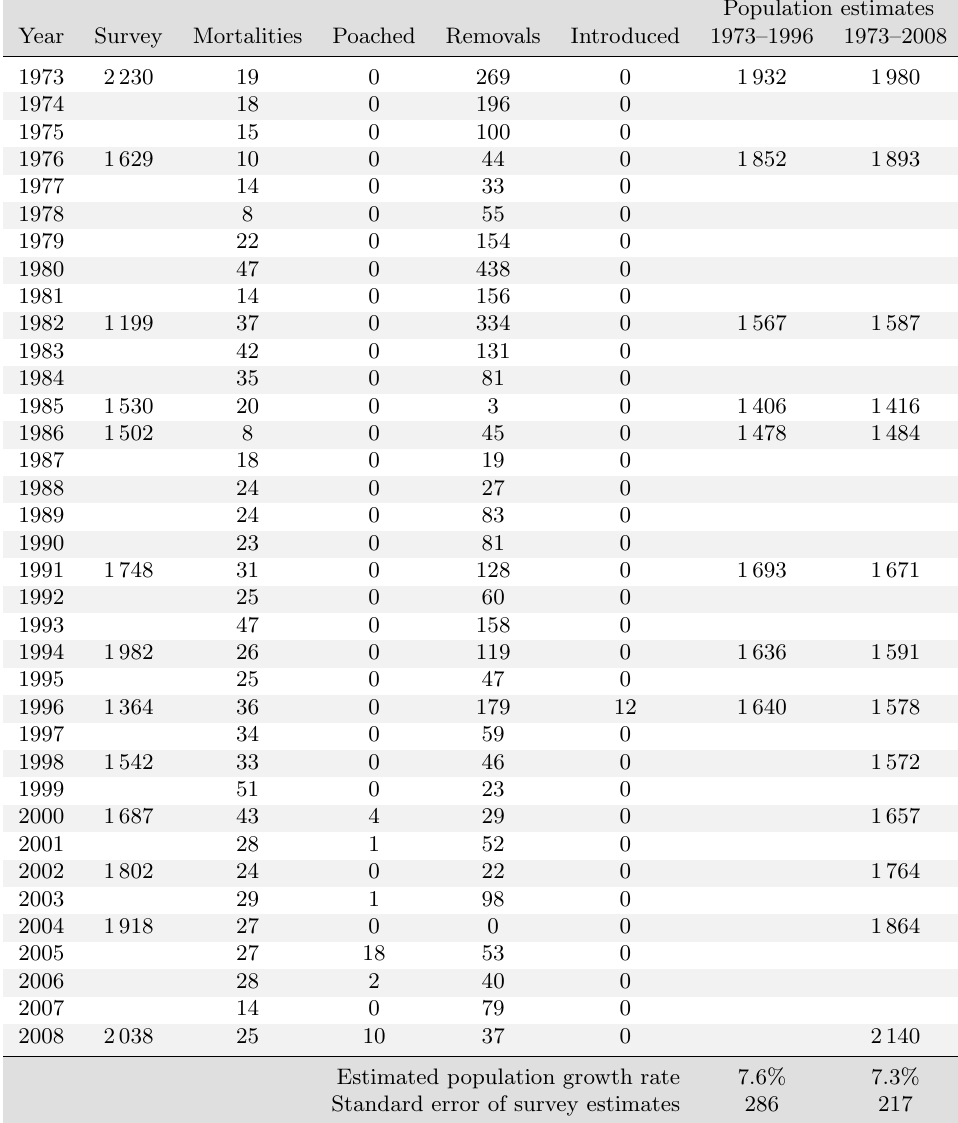
Table 1: White rhino survey data and population size estimates during the period 1973–2008.